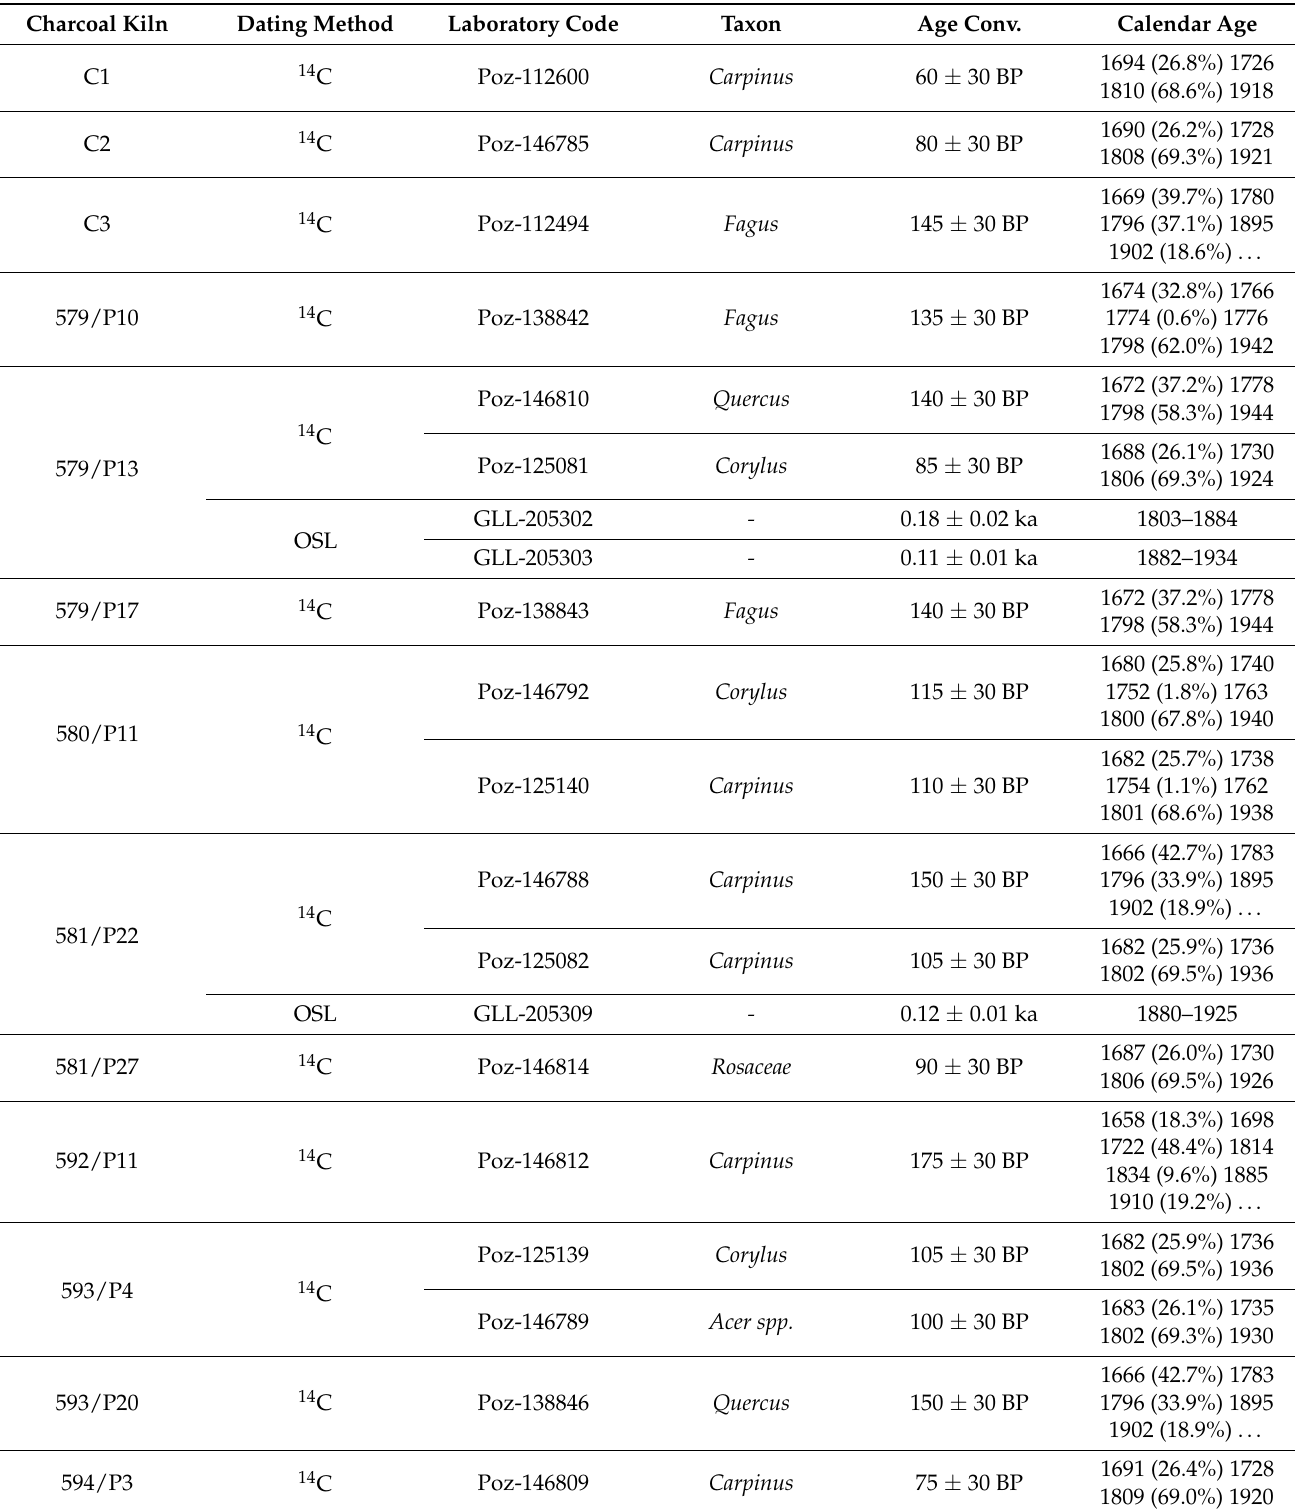
Table 1. Results from 14 C (n = 18) and OSL (n = 3) dating. All ages are expressed as calendar ages within 95.4% probability (last column). For kiln 579/P13, two OSL dates were obtained from opposite profiles at the same